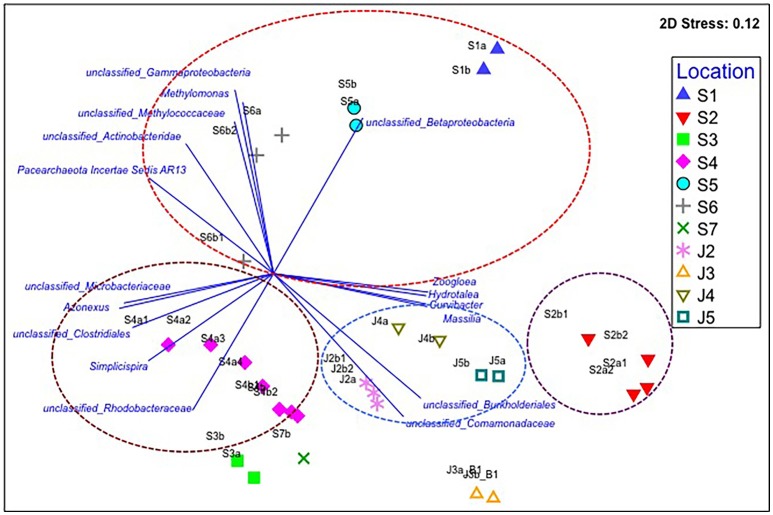
Non-metric multidimensional scaling (NMDS) plot for the averaged microbial communities in each Kathmandu (S1–S7) and Jhapa (J2–J5) water sample that was taken in (Batch 1). Vector-based analysis (blue lines and text) overlay the bacterial population that showed significant correlation with the clustering patterns. The letters a, b, c, d (e.g., S2a, S2b, S2c, S2d) represent different filter membranes used for each sample collected. More filter membranes were used at some sites (S2) compared to other sites (J3) because water turbidity was higher. Similar bacterial populations are indicated by circles of different colors.